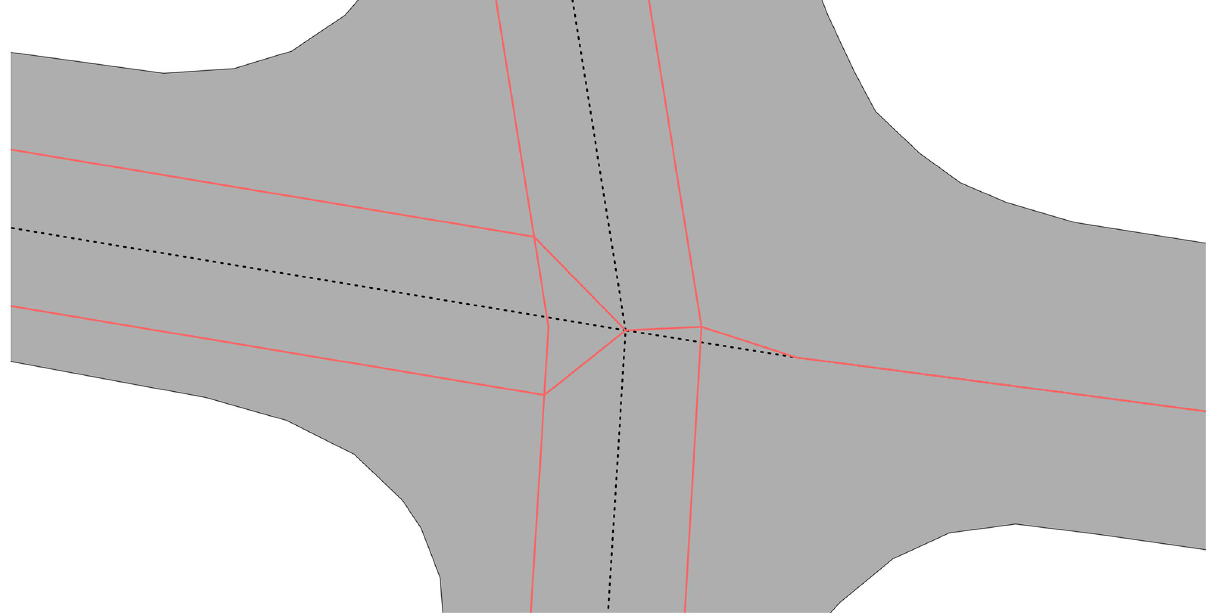
Fig 12. Fixing overall topology in the network was prioritised over pure aesthetics. Comparing Iteration 2 with Iteration 5 for a single to dual carriageway in an intersection.